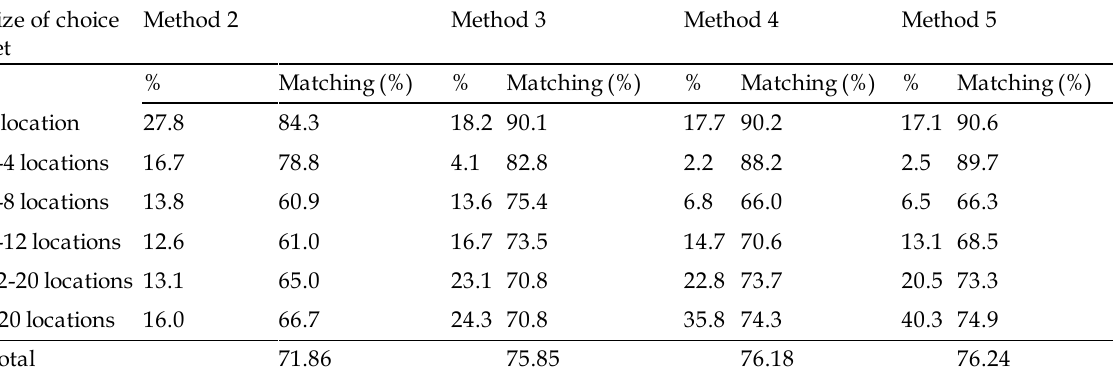
Table 5. Location choice size distribution under different location choice set generation